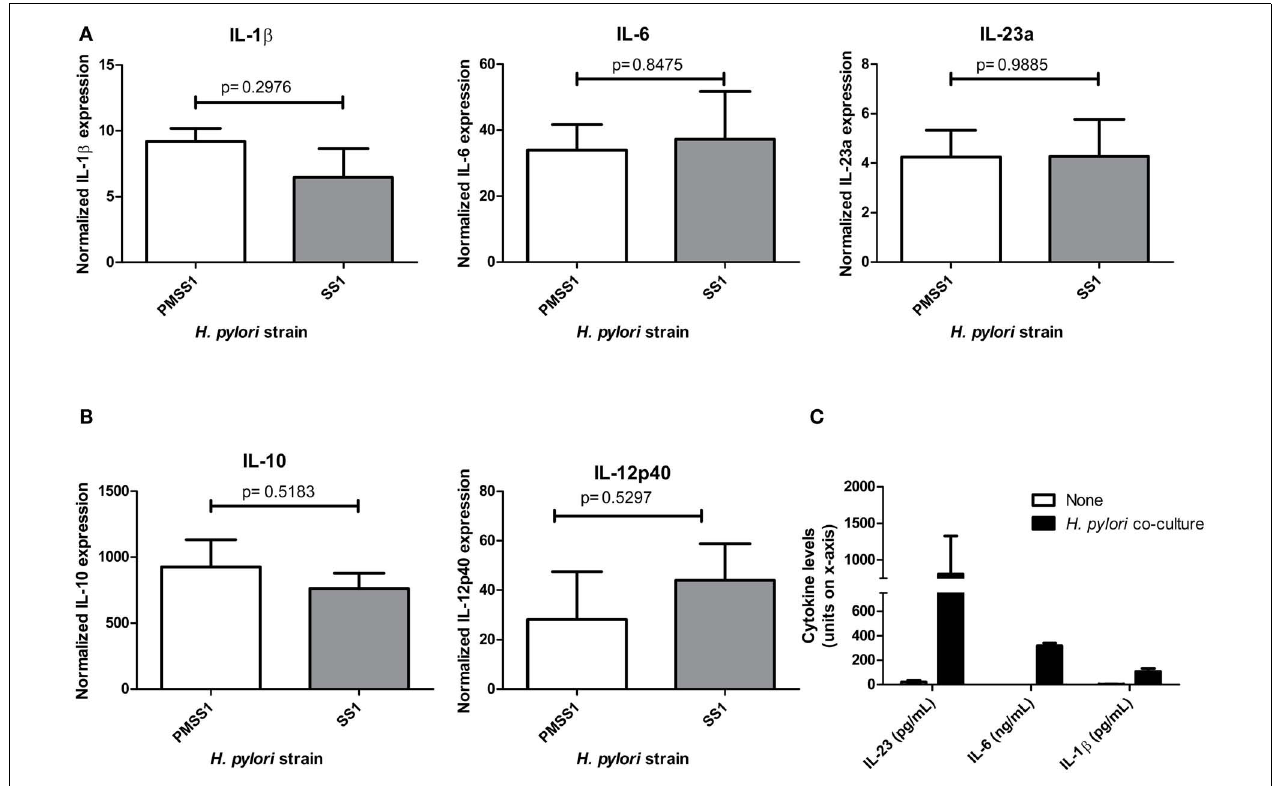
expression at 6h of co-culture with and without H. pylori. Graphs are representative of four independent experiments. (C) Th17 influencing cytokines (IL-1 β , IL-6, and IL-23a) protein levels in the supernatants from dendritic cell- H. pylori co-cultures at 24h (units for each cytokine are noted on the x